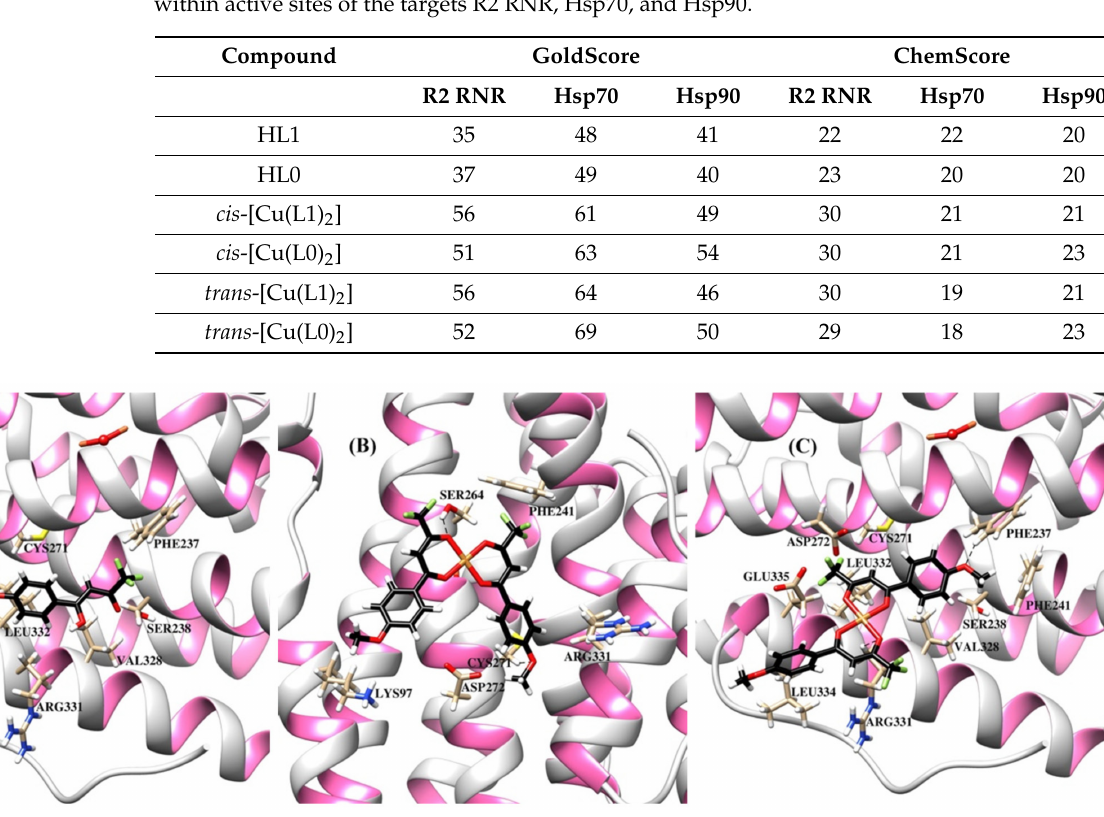
Figure 7. Ribbon representation of the R2 RNR protein with bound compounds H L1 ( A ), cis -[Cu( L1 ) 2 ] ( B ), and trans - [Cu( L1 ) 2 ] ( C ). Binding site showing selected amino acids and hydrogen bonding (dashed lines) between the compounds and Glu335, Ser264, Cys271, Arg331, and